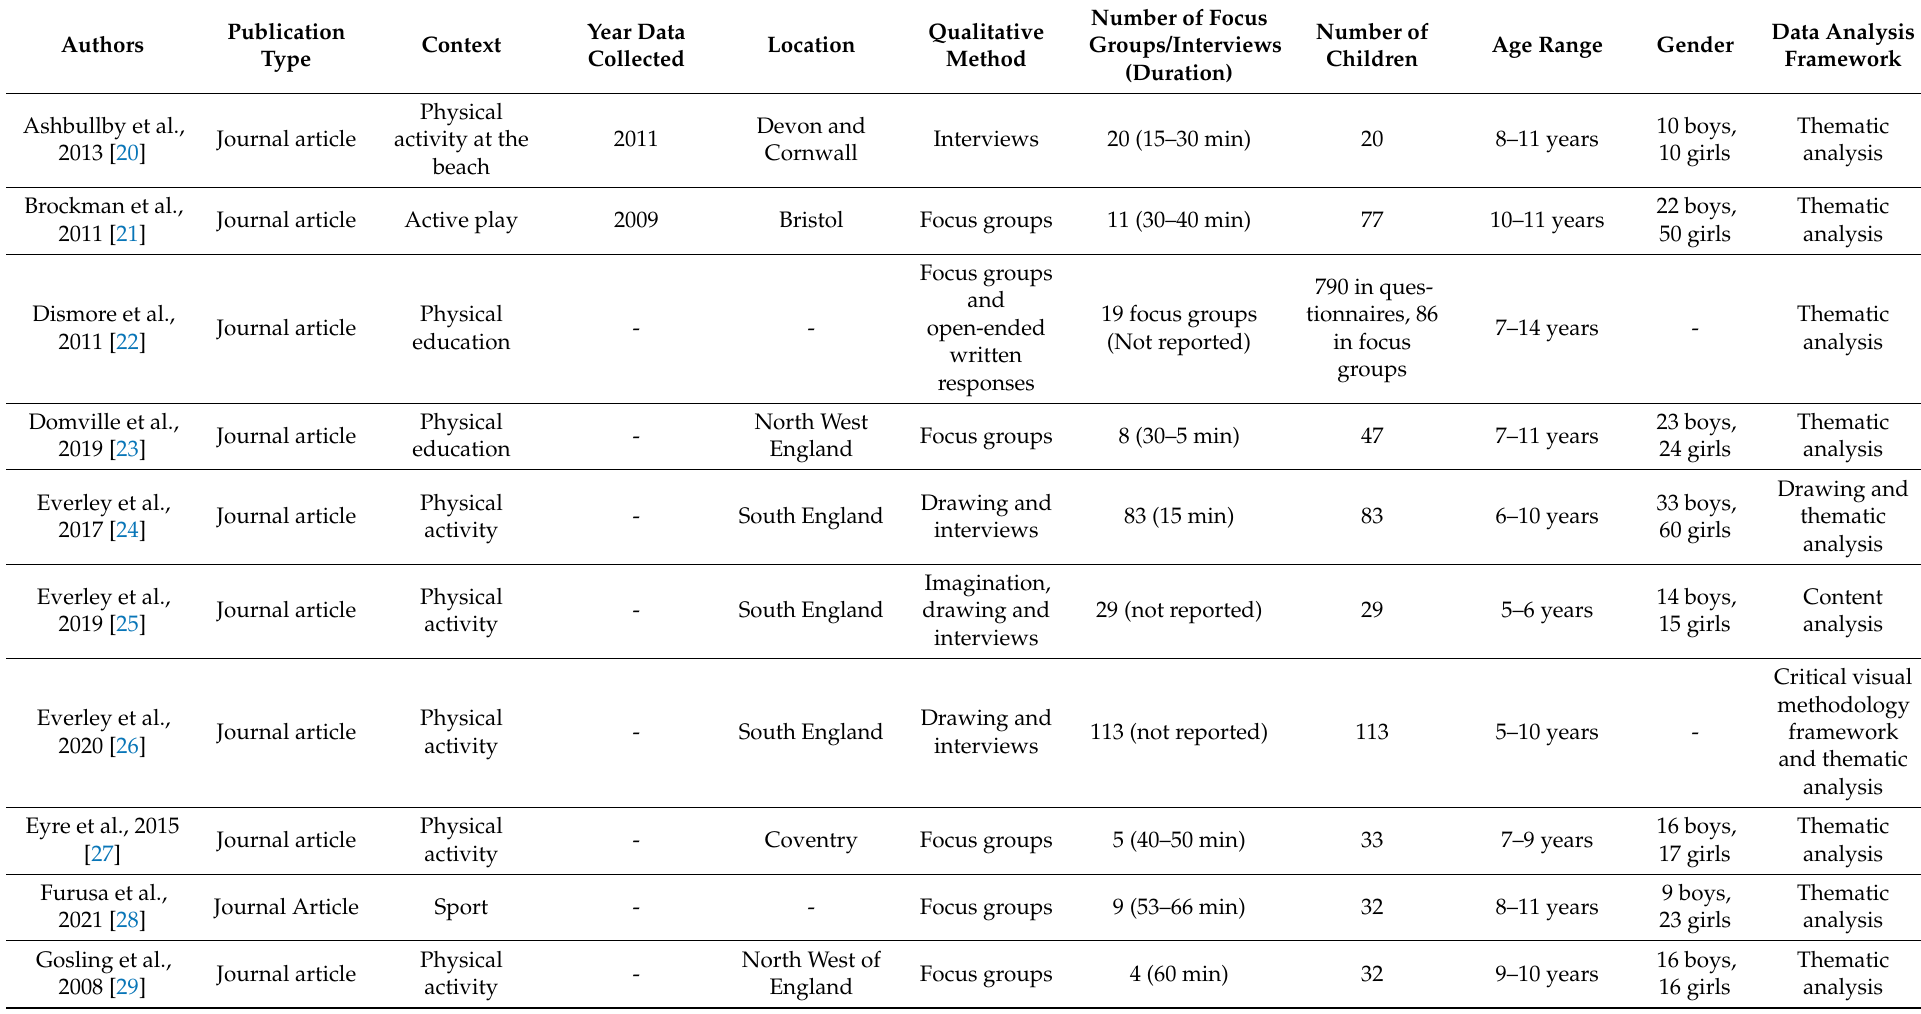
Table 3. Study and participant characteristics for the studies included in this